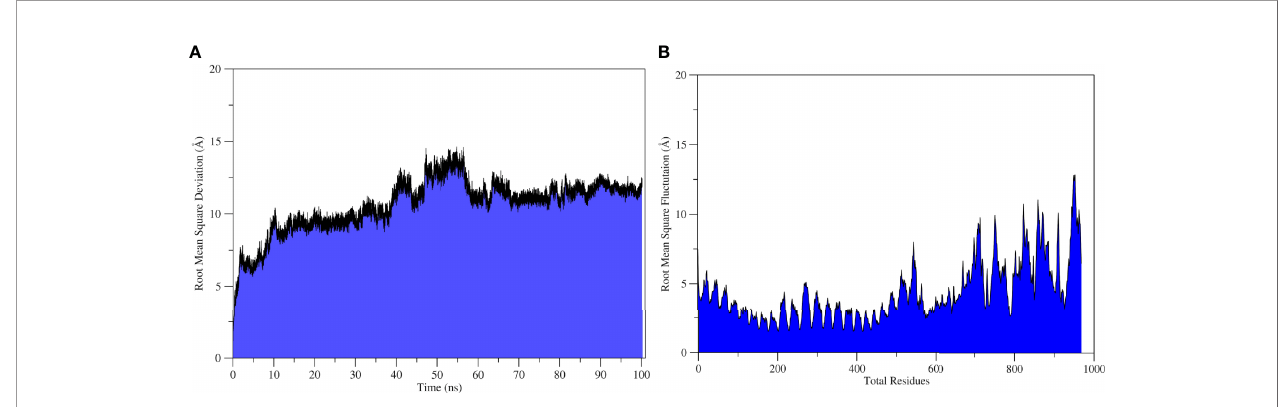
FIGURE6 | Statistical analysis of TLR2-Vaccine simulation trajectories. (A) Root Mean Square Deviation analysis, (B) root mean square fl uctuation